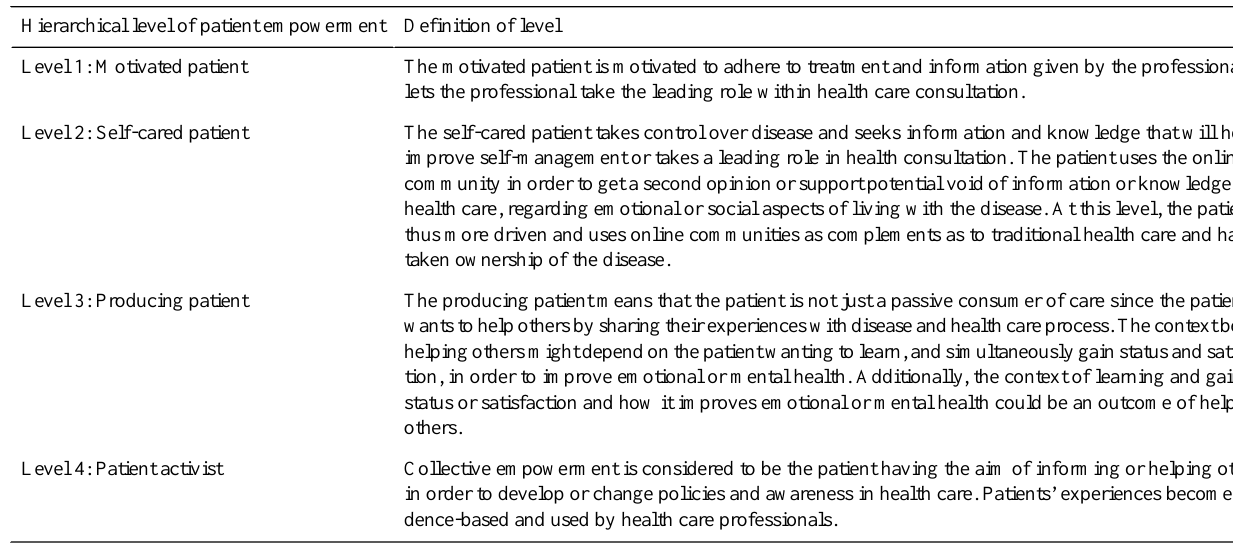
Table 5. The proposed hierarchical framework of patient empowerment levels.